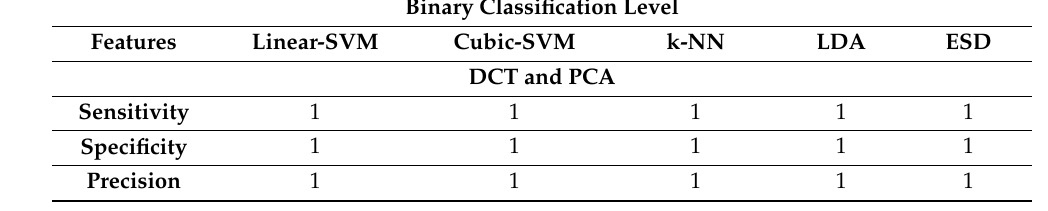
Table 10. The performance metrics for the 5 classifiers used in MB-AI-His CADx after the fusion using PCA and DCT for binary class classification level.